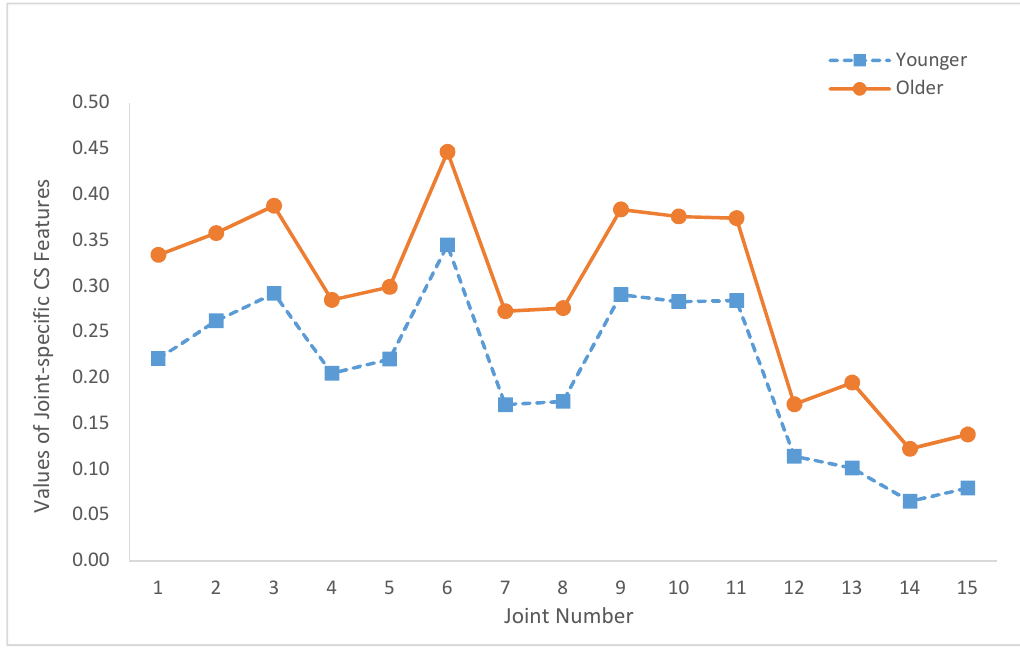
Figure 5. Summary of the joint-specific coupling strength (CS) features (JCS i , i = 1, …, 15) of both age groups.